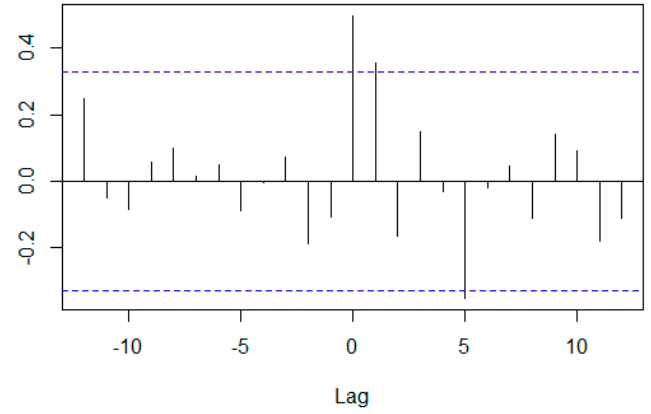
Figure 24. Cross-correlation coefficient between monthly rate of return of the whole sample group and monthly rate of return of the camera group for Jan 2010–Dec 2012.